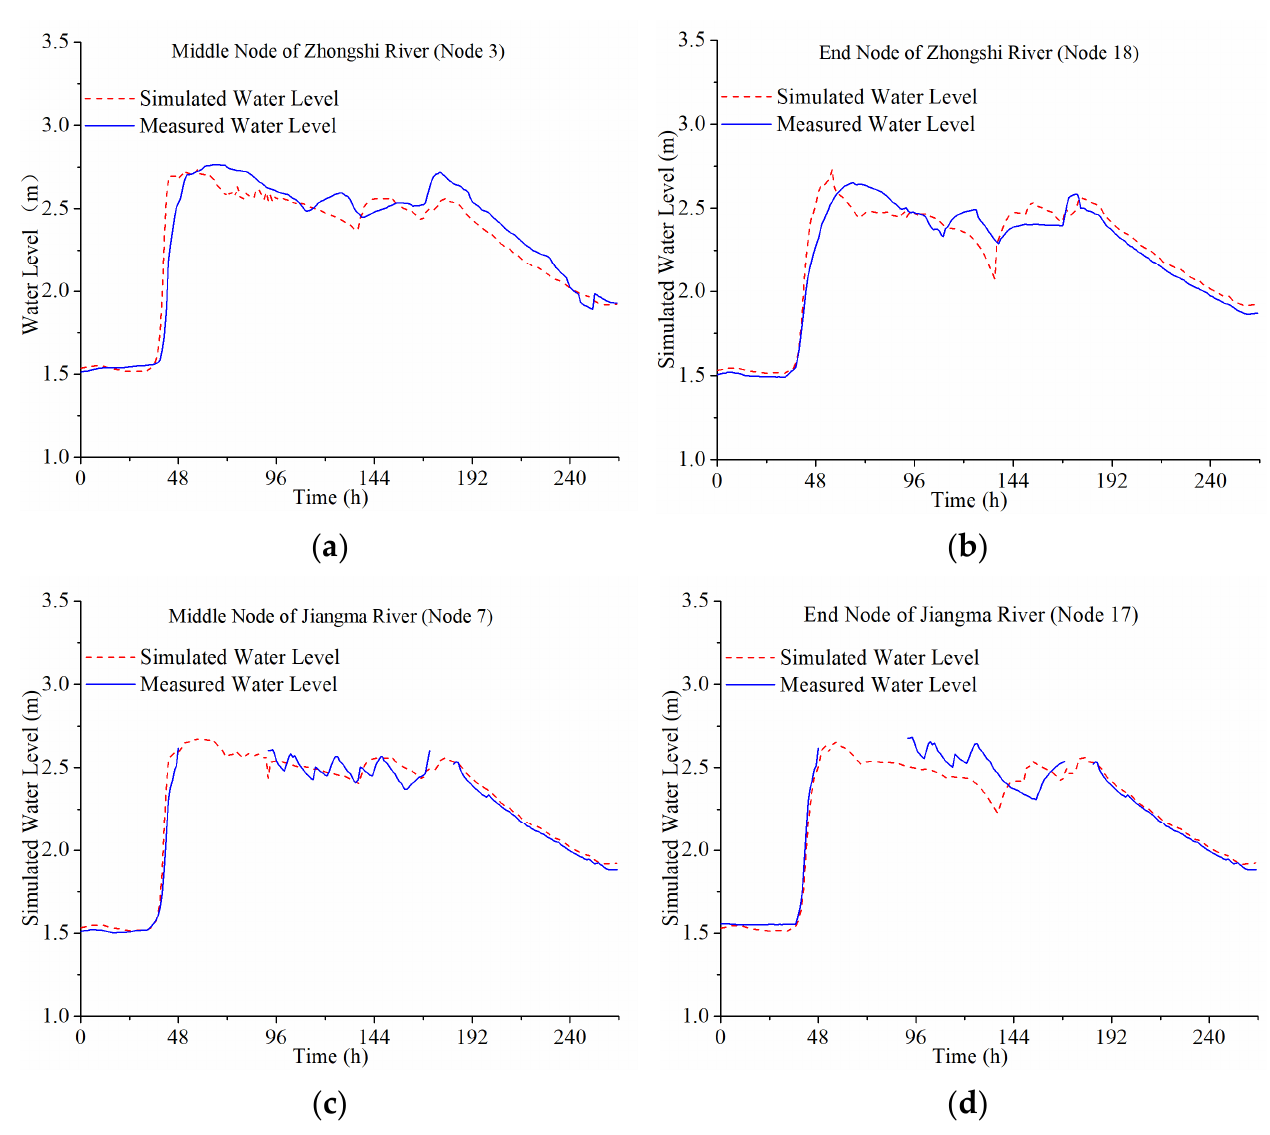
Figure 10. Curves of the measured and simulated processes of the river level at ( a ) Node 3, ( b ) Node 18, ( c ) Node 7, ( d ) Node 17 (Example 2). The breaks in the curves are due to the observation water level exceeding the measuring range of the Odyssey water level gauge.